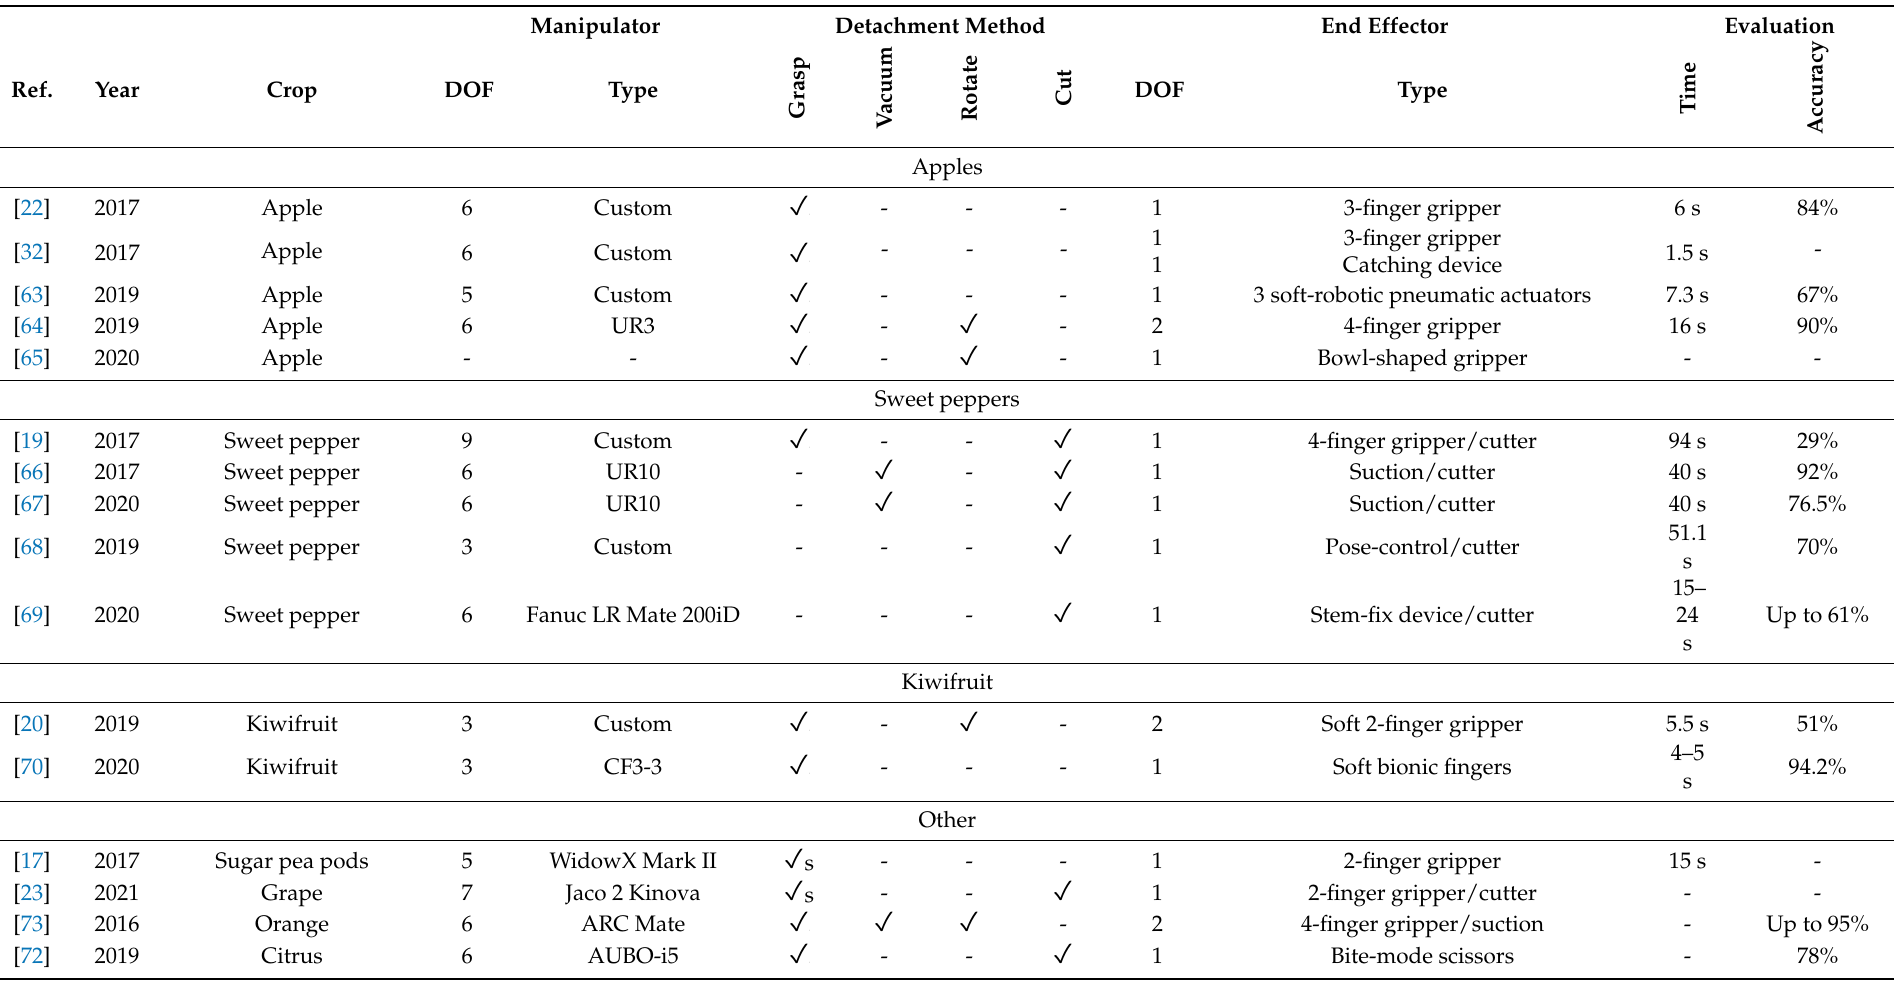
Pumpkin, cabbage RAVebots-1 ✓